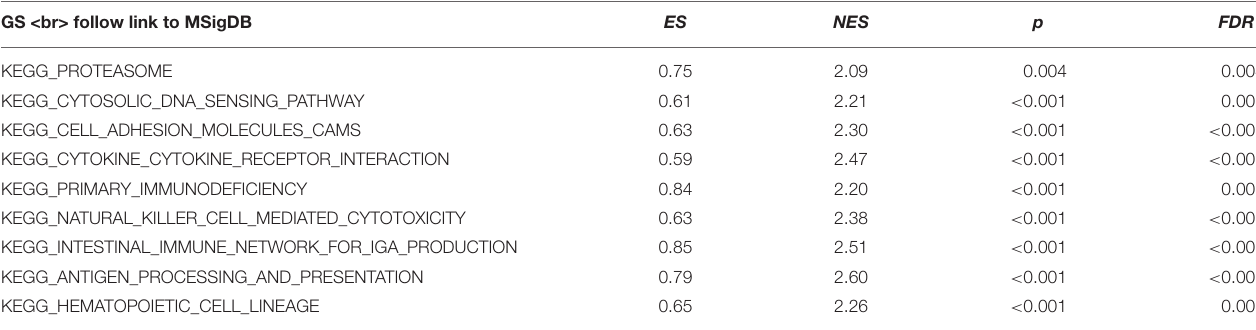
TABLE 3 | GSEA pathways upregulated due to high expression of HCST. GS <br> follow link to